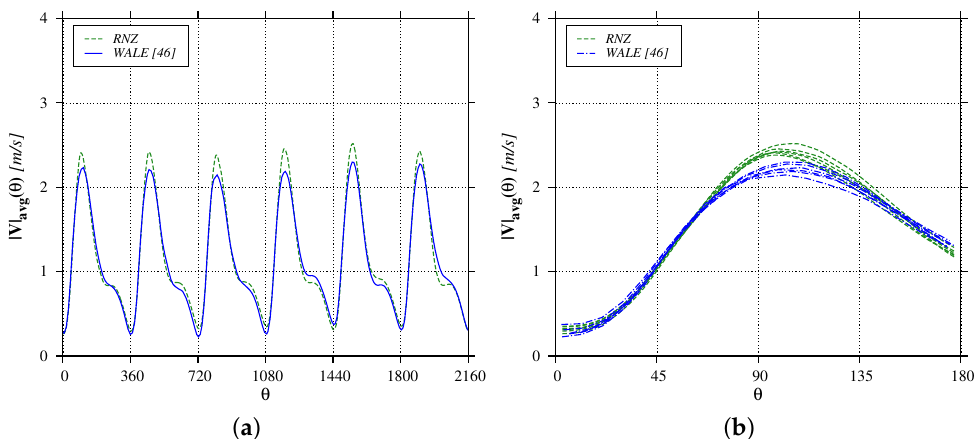
Figure 15. Details of CCV in terms of the volume-averaged in-cylinder velocity magnitude: ( a ) evolution of six consecutive cycles; ( b ) intake stroke variability.